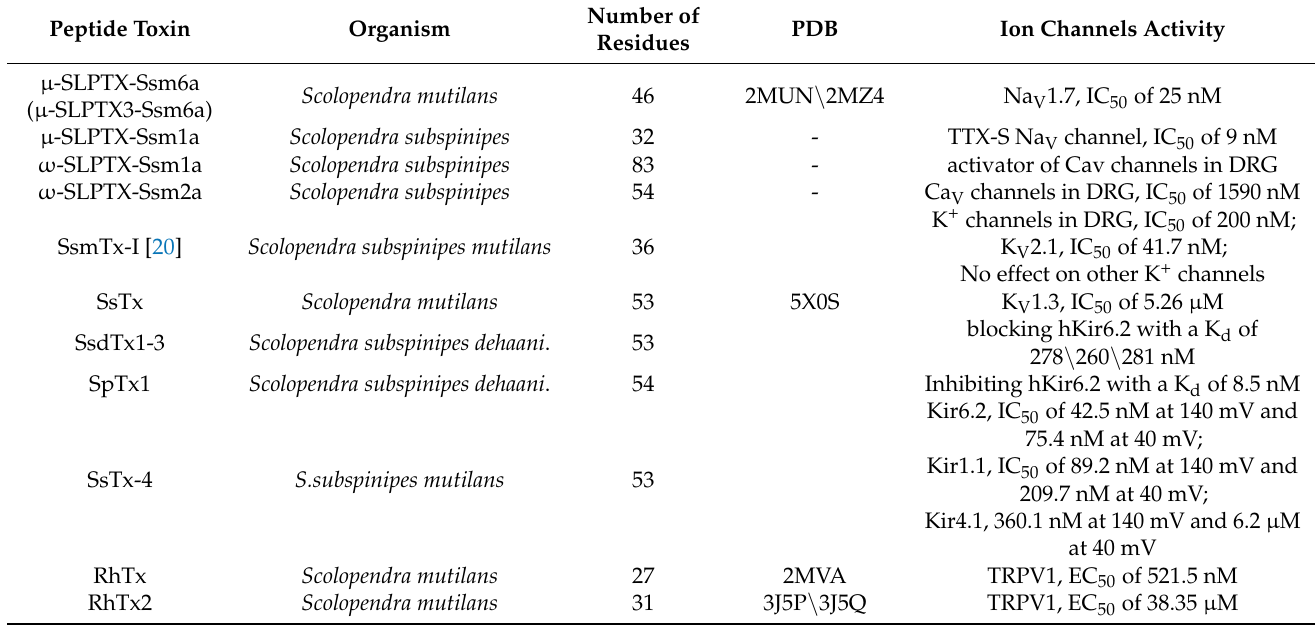
Table 1. Centipede toxins acting on ion